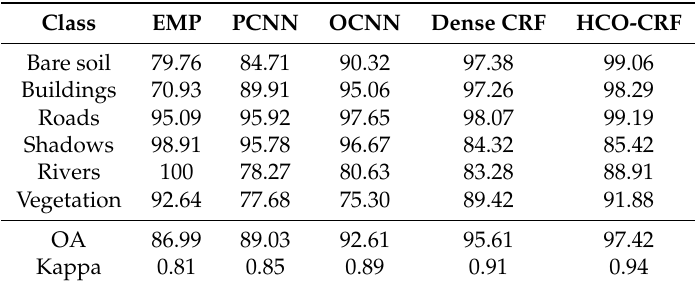
Figure 6. Classification results on Beijing dataset with different strategies. ( a ) EMP-based classification; ( b ) pixel-based CNN classification; ( c ) the object-based CNN classification; ( d ) Dense CRF classification; ( e ) HCO-CRF classification result. Table 7. Classification results of Beijing dataset with different strategies (in percentage). OA: Overall